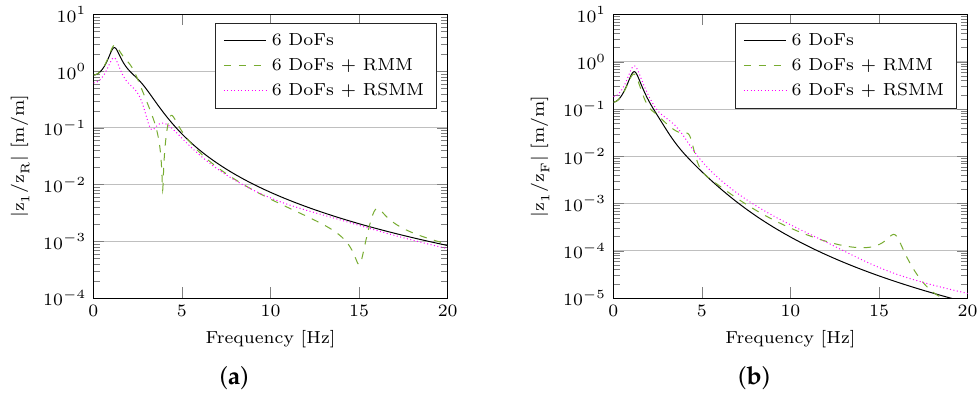
Figure 11. Transmissibility between the wheels of the 6-DoFs tractor and the operator’s seat z 1 with a rear-mounted (RMM) or a rear semi-mounted (RSMM) operating machine: ( a ) rear wheels z 1 / z R ; ( b ) front wheels z 1 / z F .